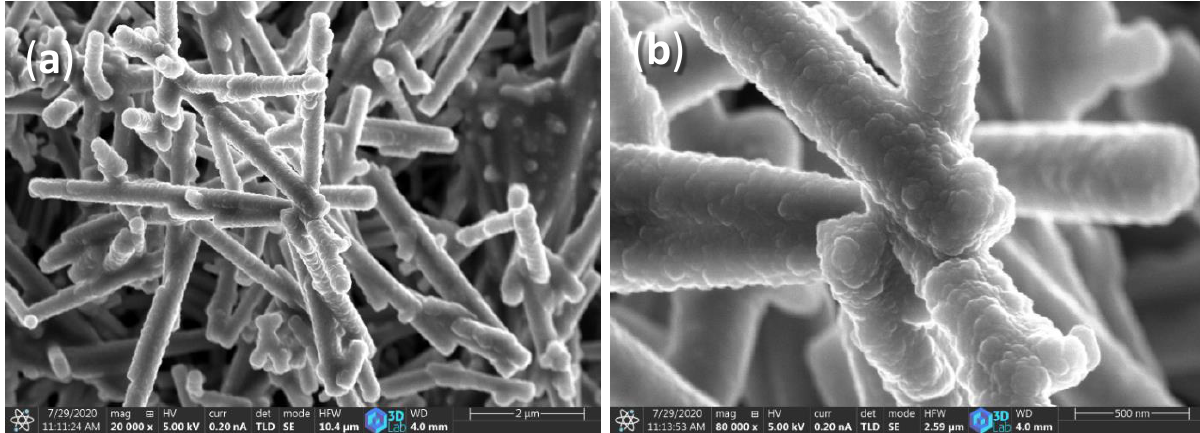
Figure 3. SEM images of WO 3 NW ( a ) lower and ( b ) higher magnifications.